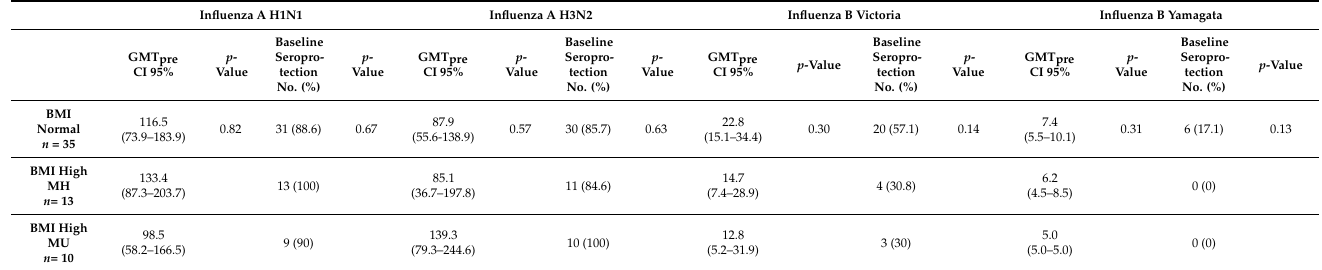
Figure 1. Characterization of influenza responses in the entire cohort of children measured by hemagglutination inhibition (HI) assays. HI titers before vaccination (at baseline), ~1 month, and 6 months after vaccination are shown for each of the vaccine strains contained in the quadrivalent influenza vaccine (Fluzone) for three consecutive seasons (2017–2018, 2018–2019, 2019–2020). **** p < 0.0001; *** p < 0.001, * p < 0.05. ns: indicated Not Significant. Table 2. Pre-existing antibody responses before vaccination against influenza A/H1N1 and H3N2 and influenza B/Victoria and Yamagata lineages according to BMI and metabolic status. A total of 58 subjects had serum sampled before vaccination. From these 58 subjects, 35 were classified as BMI normal, 13 subjects as BMI high MHOO (metabolic healthy obese/overweight) and 10 as BMI High MUOO (metabolic unhealthy obese/overweight).